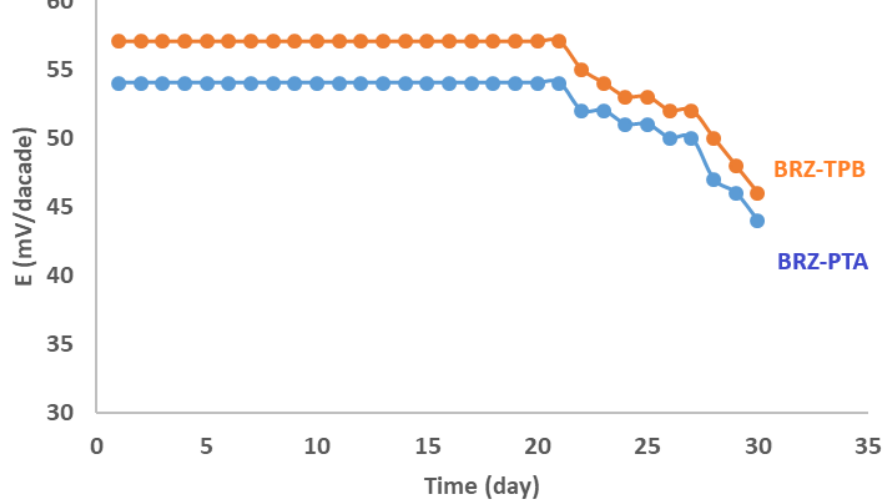
Figure 4. Stability of the bromazepam-phosphotungstate (BRZ-PTA) and bromazepam-tetraphenyl borate (BRZ-TPB membrane sensors.